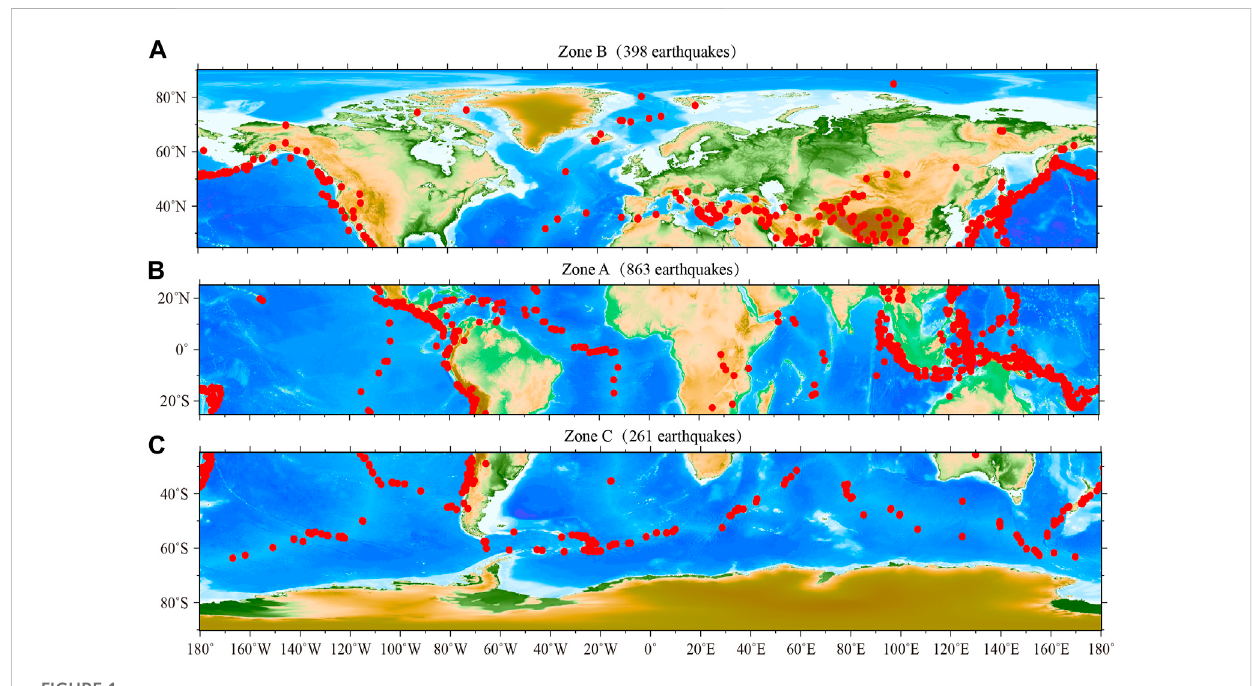
FIGURE 1 Locations of global 1522 Mw ≥ 6.0 earthquakes during 2000 –